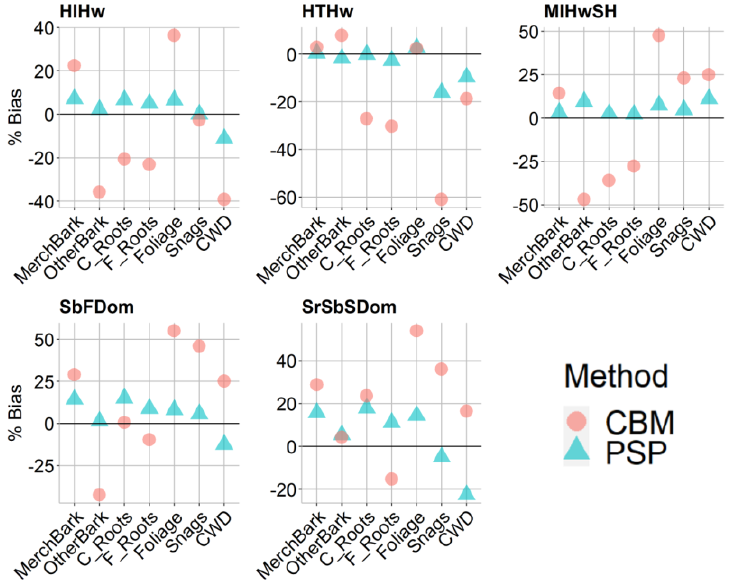
Figure 9. %Bias of PSP- and CBM-derived estimations of pool-level carbon when compared to an independent, observed PSP dataset ( n = 100 per forest community), by forest community and carbon